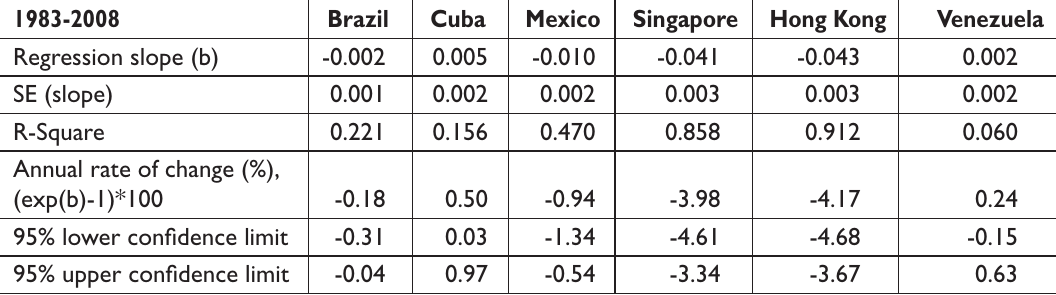
Log-Linear Regression Trend Models of Cervical Cancer Mortality, 1983-2008